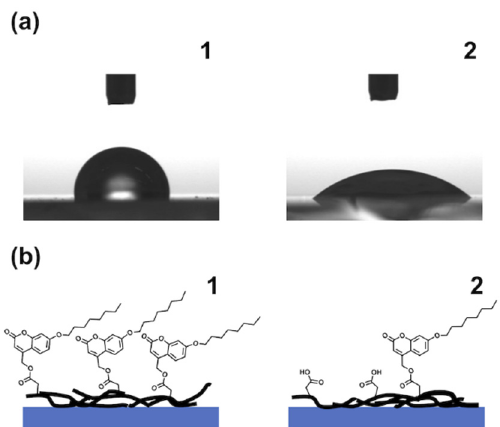
Figure 6. ( a ) Change in the water contact angle of the PC 56 T 44 /SWCNT composite film. ( b ) Illustration showing the photocleavage of the PC 56 T 44 /SWCNT composite film. ( 1 ) Before and ( 2 ) after irradiation at 313 nm.